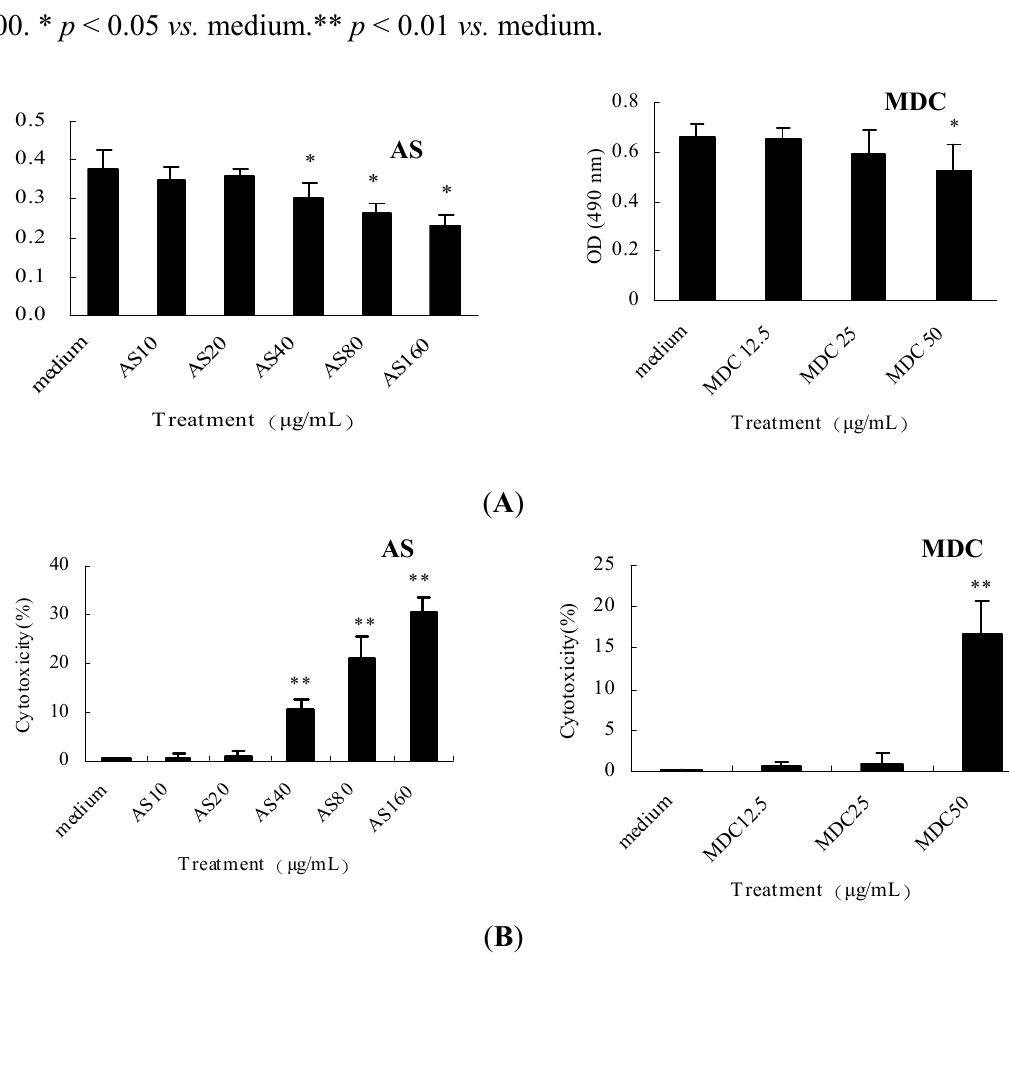
Figure 9. Cytotoxicities of AS and MDC on mouse peritoneal macrophages using MTT ( A ) and LDH ( B ) assay. The peritoneal macrophages (5.0 × 10 4 cells/well) were grown in 96-well plates. After overnight incubation in RPMI 1640, the cells were washed and incubated with NS or various concentrations of AS or MDC for 6 h. ( A ) Subsequently, 20 μ L of MTT solution (5 mg/mL in PBS) was added to the medium in a total volume of 200 μ L. After the cells were incubated for 4 or 24 h at 37 °C, the supernatant was removed, and 150 μ L DMSO was added to each well to dissolve the produced formazan crystals. The extinction was measured at 490 nm using a microplate reader (Bio-Rad, Hercules, CA, USA); ( B ) After the cells were centrifuged at 400× g for 5 min, the clear supernatant (120 µL/well) was transferred into corresponding wells of an optically clear 96-well plate. 60 µL of the LDH reaction mixture was added to each well and incubated for up to 30 min at room temperature (the plate was protected from light). The extinction was measured at 490 nm using a Model 550 microplate reader (Bio-Rad, Hercules, CA, USA). The percentage cytotoxicity was calculated according to the protocol of the manufacturer’s instructions: Cytotoxicity (%) = (Test Sample – Low Control)/(High Control − Low Control) × 100. * p < 0.05 vs. medium.** p < 0.01 vs. medium.